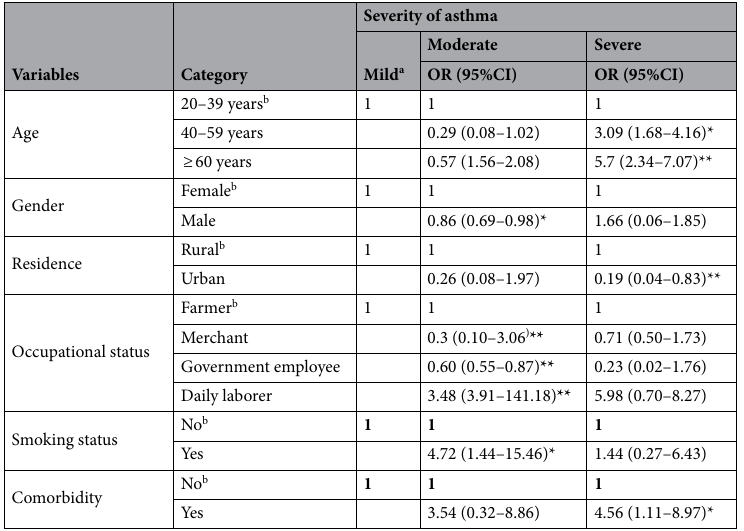
Table 3. Multinomial analysis of factors associated with severity of asthma of adult patients assisted at the Adult Emergency Department of the Jimma Medical Center, Jimma Town, Ethiopia during 25 July, 2021 to 25 August, 2021. *P < 0.05, **P < 0.001. a Reference for dependent variable. b Reference for the category of independent variable. Significant values are in